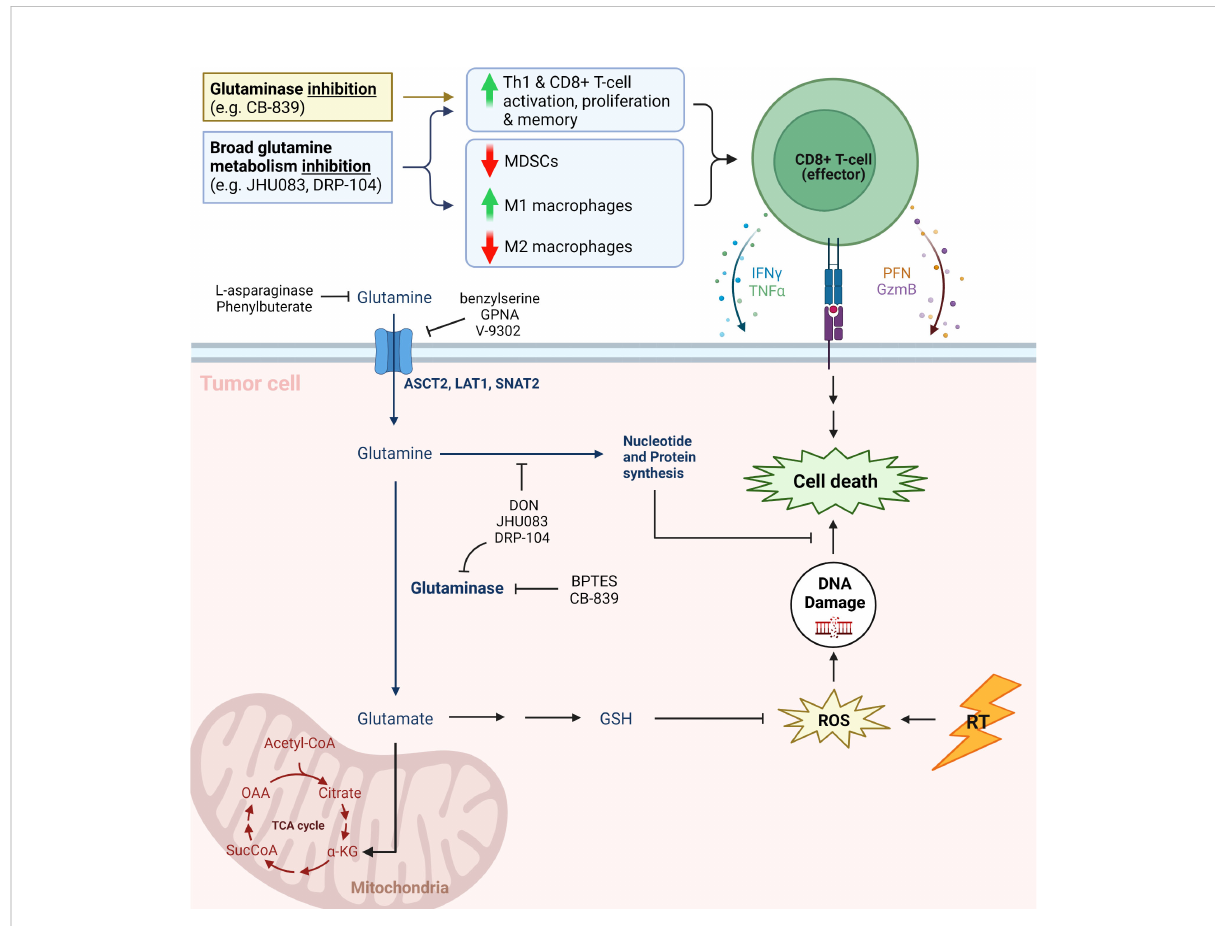
FIGURE 1 Simpli fi ed cartoon showing key aspects of glutamine metabolism and associated therapeutic strategies (11). CB-839, telaglenastat; DRP-104, sirpiglenastat; MDSCs, myeloid derived suppressor cells; IFN g , interferon gamma; TNF Α , tumor necrosis factor alpha; PFN, perforin; GzmB, Granzyme B; GPNA, L- g -glutamyl-p-nitroanilide; DON, 6-diazo-5-oxo-L-norleucine; BPTES; bis-2-(5-phenylacetamido-1,3,4-thiadiazol-2-yl) ethyl sul fi de; GSH, glutathione (reduced); ROS, reactive oxygen species; RT, radiation therapy; TCA cycle, tricarboxylic acid cycle; Α -KG, alpha ketoglutarate; SucCoA, Succinyl-CoA; OAA, oxaloacetate. Adapted from “ Warburg Effect ” , by